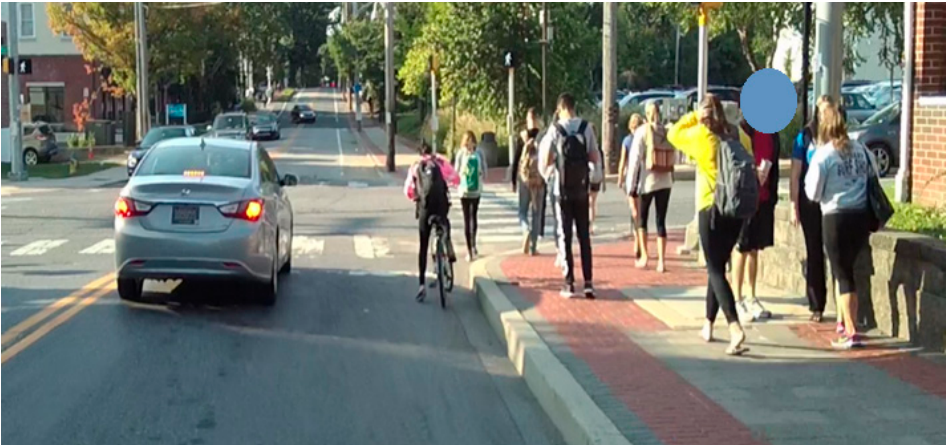
Figure 3. High-resolution image taken with Pivothead glasses.